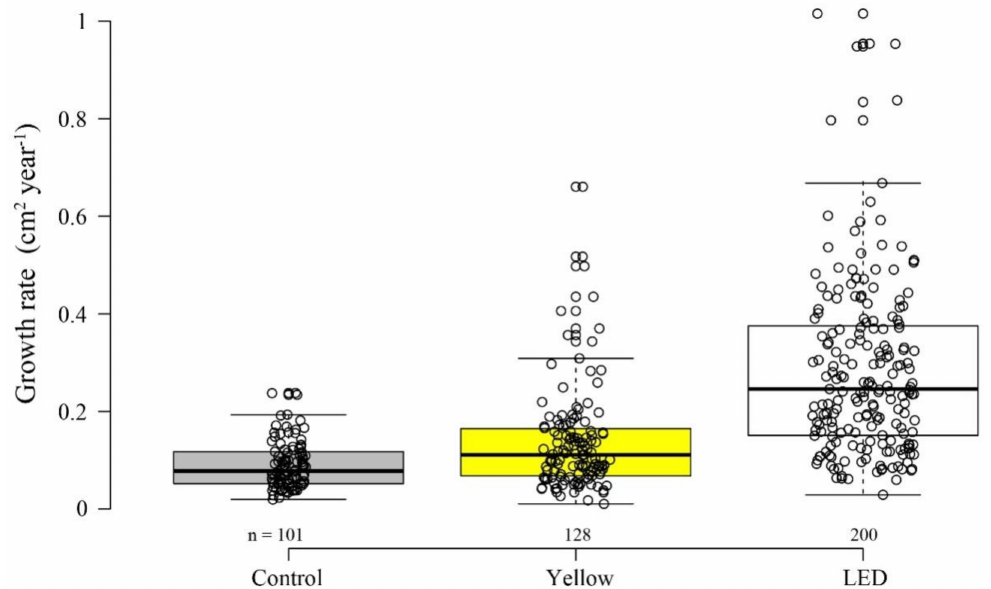
Figure 3. S. pistillata growth rate after one year (June 2017–June 2018) under ambient conditions— control (gray), and light treatments ‘Yellow’ (fluorescent lamp, yellow), and ‘LED’ (LED lamp, white). The circles represent individual colony growth rate (projected surface area; cm 2 year − 1 ) (n = number of